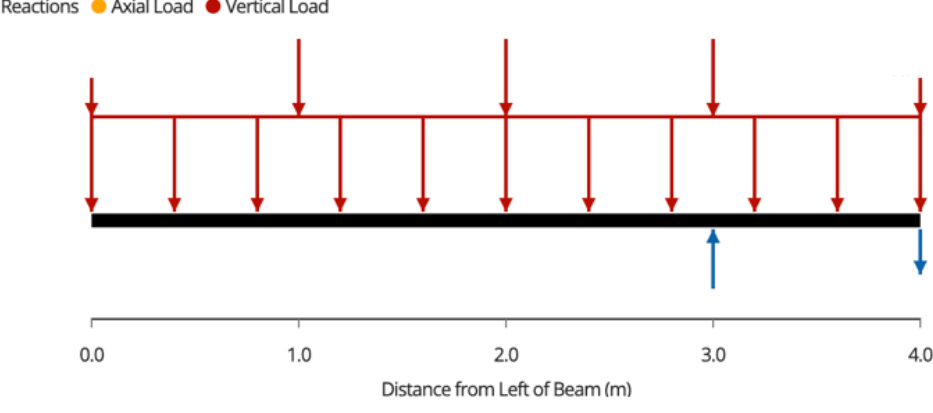
distributed load representing its self-weight. Beams are supported by a post, which is pulled down by a steel cable.